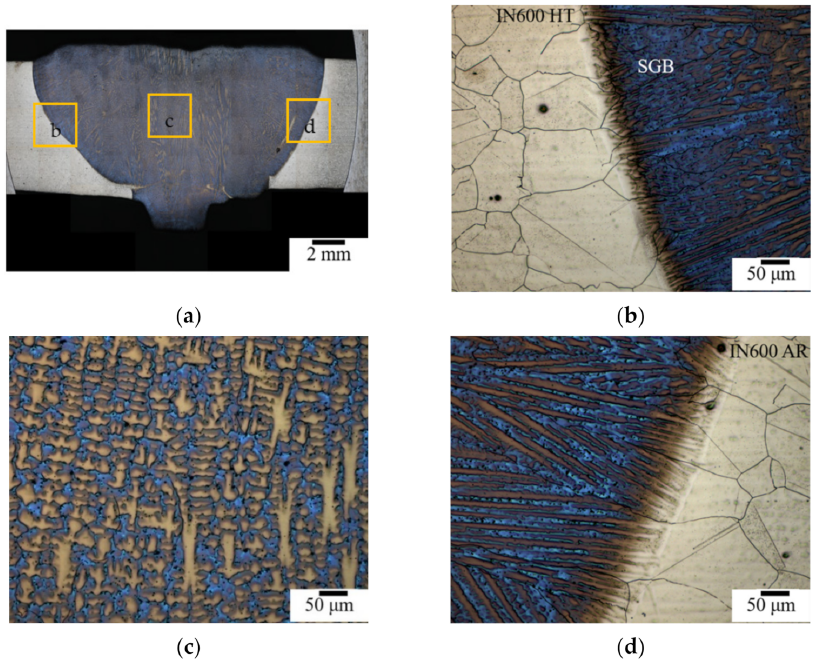
Figure 3. ( a ) Macrograph of the welded joint obtained with the ERNiCrMo-3 filler and ( b – d ) mi- crostructural details as observed in the